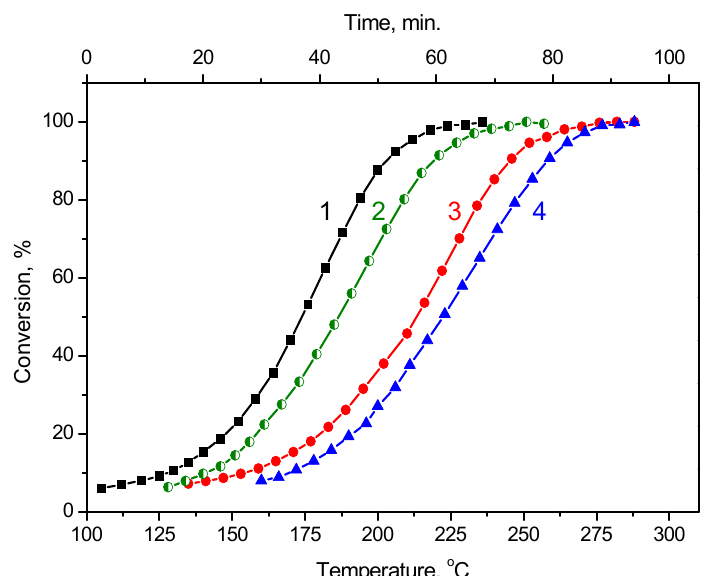
Figure 12. Dependence of the FA conversion on temperature over catalysts prepared using H 2 PtCl 6 as the precursor: 1% Pt/N-graphene (H 2 PtCl 6 ) (1); 0.4% Pt/N-graphene (H 2 PtCl 6 ) (2); 0.2% Pt/N-graphene (H 2 PtCl 6 ) (3); N-graphene (4).